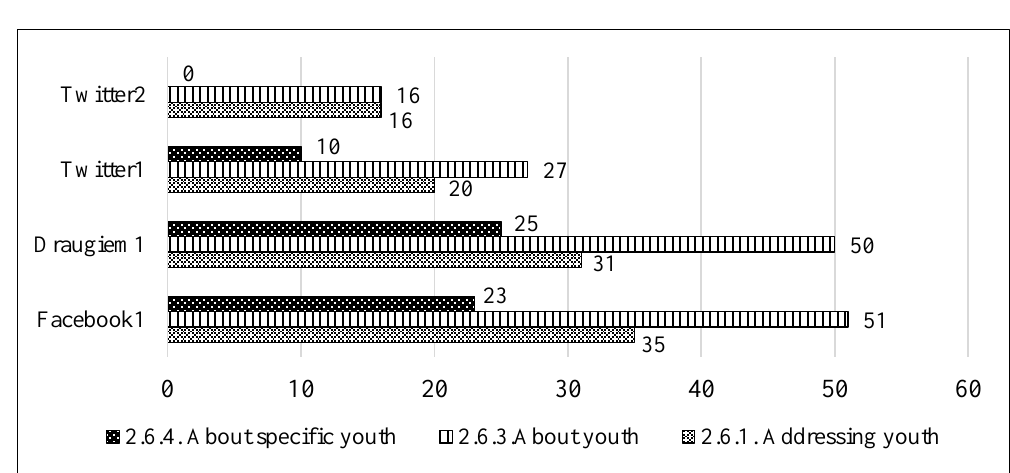
Fig. 4. European Parliament’s social media accounts from 1 July to 31 December 2015. The number of entries that are about youth or are addressing youth